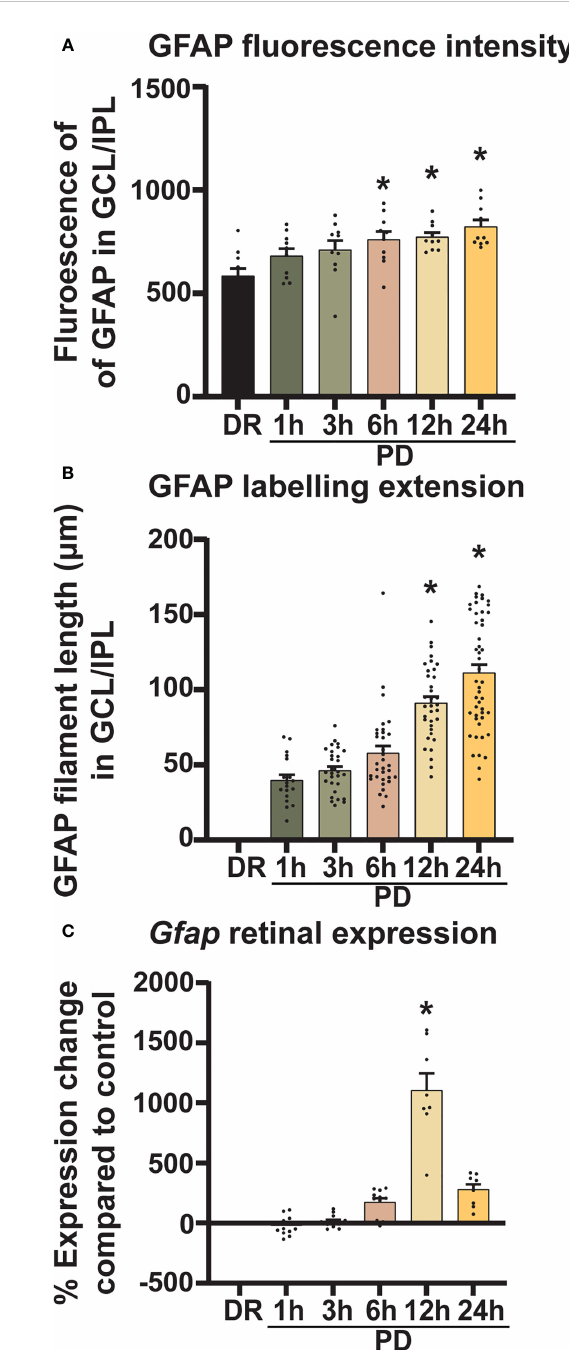
FIGURE 4 GFAP labelling demonstrates intensifying Müller cell stress from 6h-PD. GFAP labelling was used to indicate retinal Müller glia cell stress. (A) Fluorescence mean color intensity [white box; (G) ] of GFAP in the GCL and IPL of the superior retina was found progressively increase across PD, with signi fi cant intensity compared to DR controls from 6h-PD to 24h-PD ( p < 0.05, n = 4). In addition, (B) GFAP labelling length (dashed white box, H) also progressively increased across PD, and was signi fi cant at 12h-PD and 24h-PD compared to DR controls ( p < 0.05, n = 4). (C) qRT-PCR shows increased Gfap expression in retinal lysates at 12h-PD ( p < 0.05, n = 12). (D – I) Representative confocal images of the superior retina shows progressively increased GFAP labelling intensity and GFAP length in the GCL and IPL from 6h-PD to 24h-PD compared to DR controls. *Signi fi cance using a one-way ANOVA, p < 0.05 and error bars indicate SEM. Scale bar = 50 m M. n =